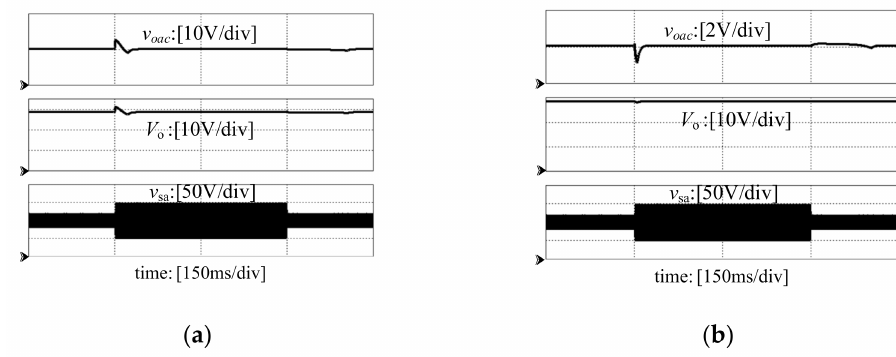
Figure 22. Simulation results of input voltage dynamic test. ( a ) Without IVFF. ( b ) With IVFF.